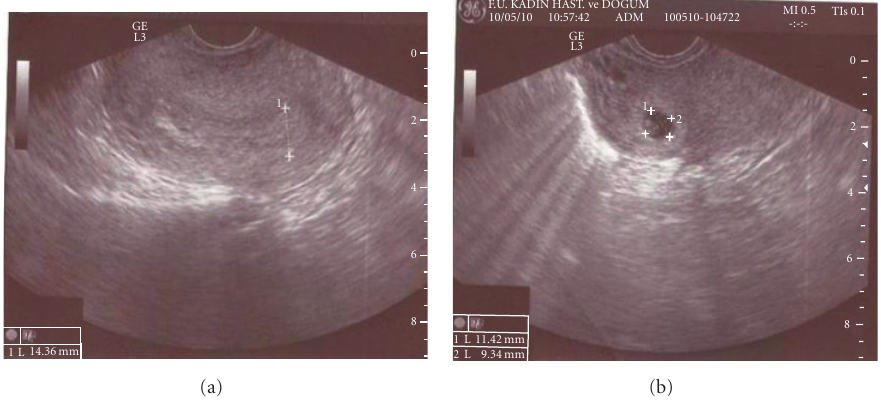
Figure 1: 15mm endometrial thickness and 11 × 9mm cornual gestational sac.